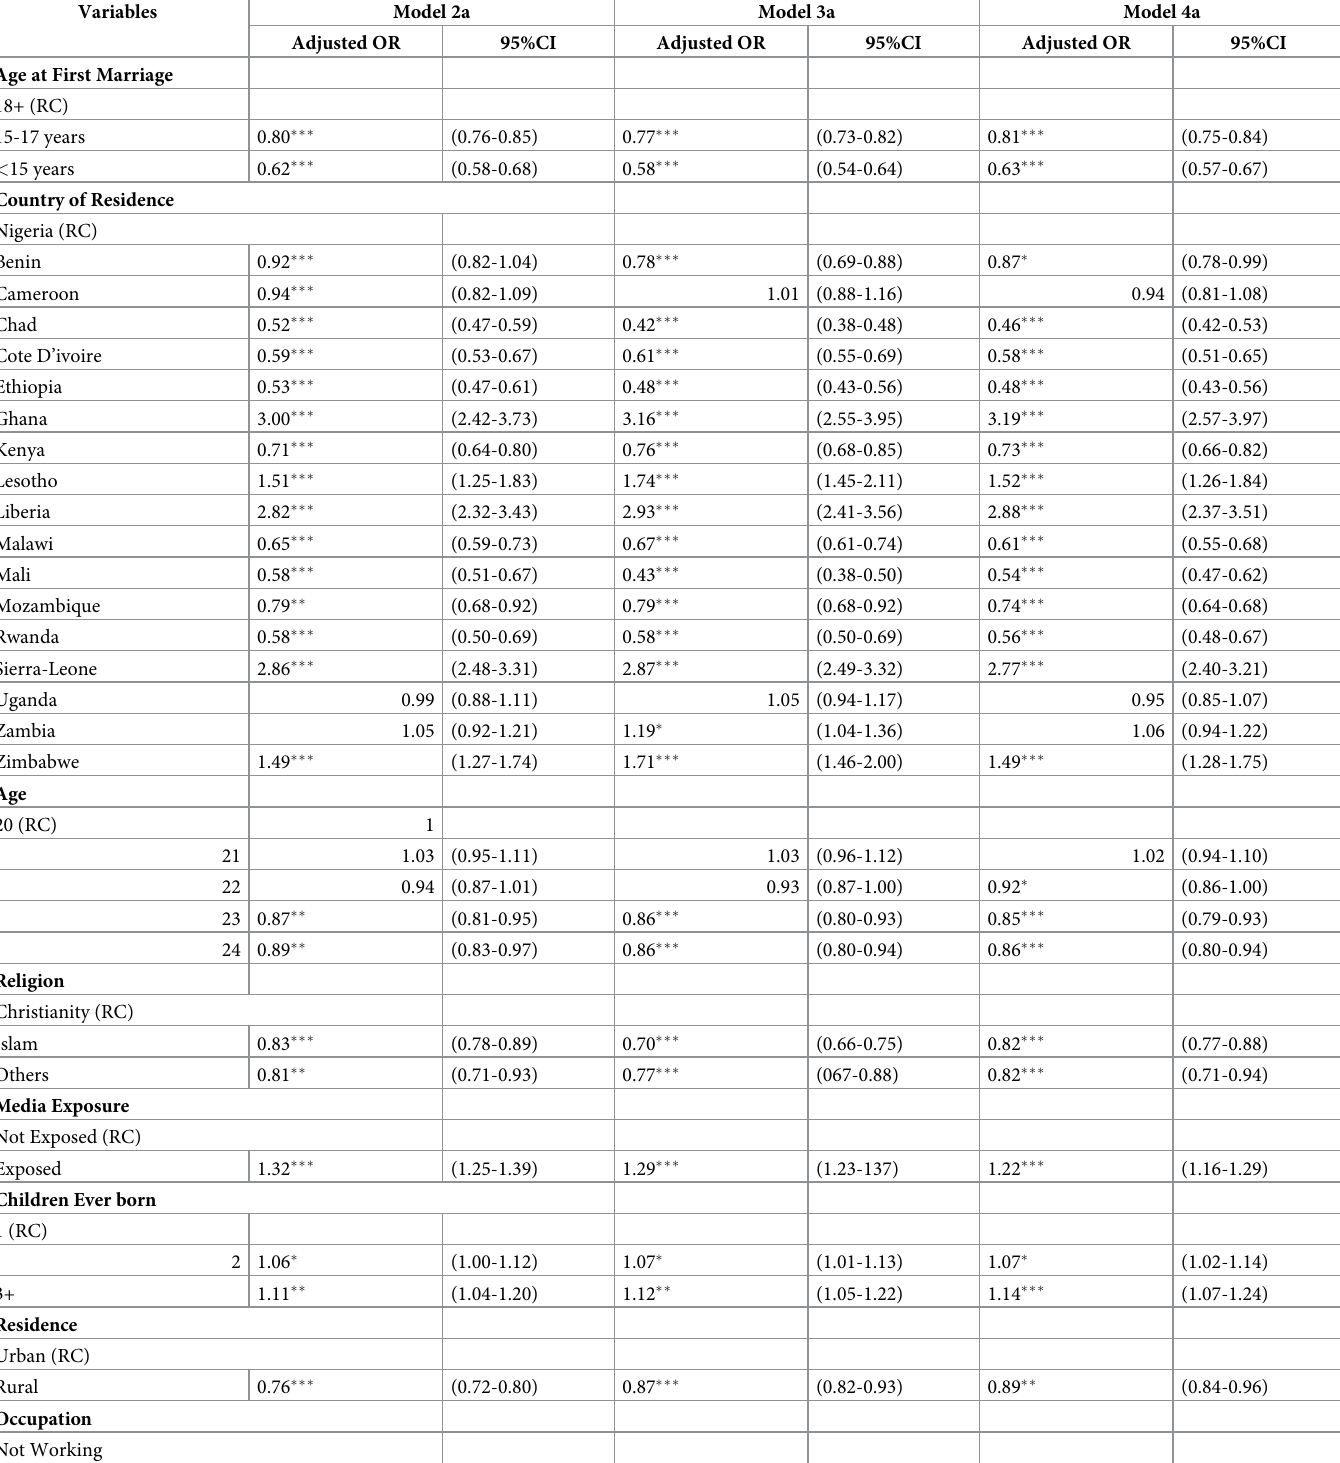
Table 5. A. Logistic regression model examining the influence of age at first marriage and selected characteristics on adequacy/number of ANC visit among young married women in selected SSA countries. B. Logistic regression model examining the influence of age at first marriage and selected characteristics on timing of first ANC visit among young married women in selected SSA